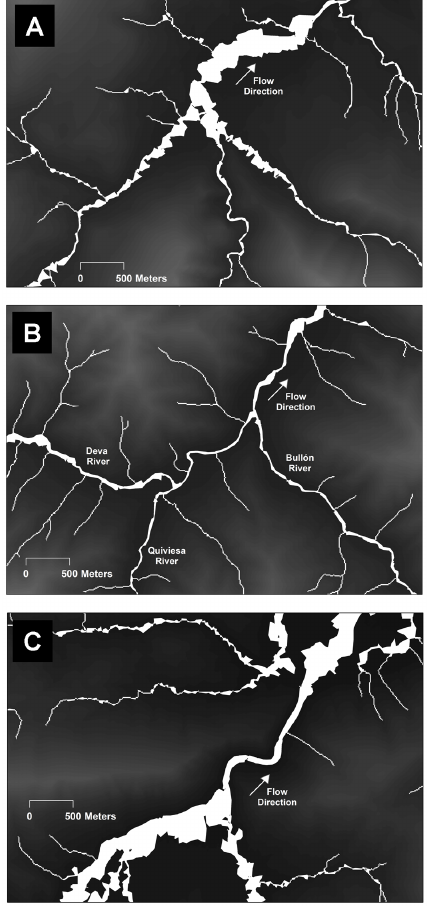
Fig. 11. Illustration of the flood-prone area at 1.25-BFD over the digital elevation model: at a river confluence deriving in wider flood-prone areas ( A ), at a river confluence not deriving in wider flood-prone areas ( B ) and at an unconstrained-constrained- unconstrained valley transition ( C